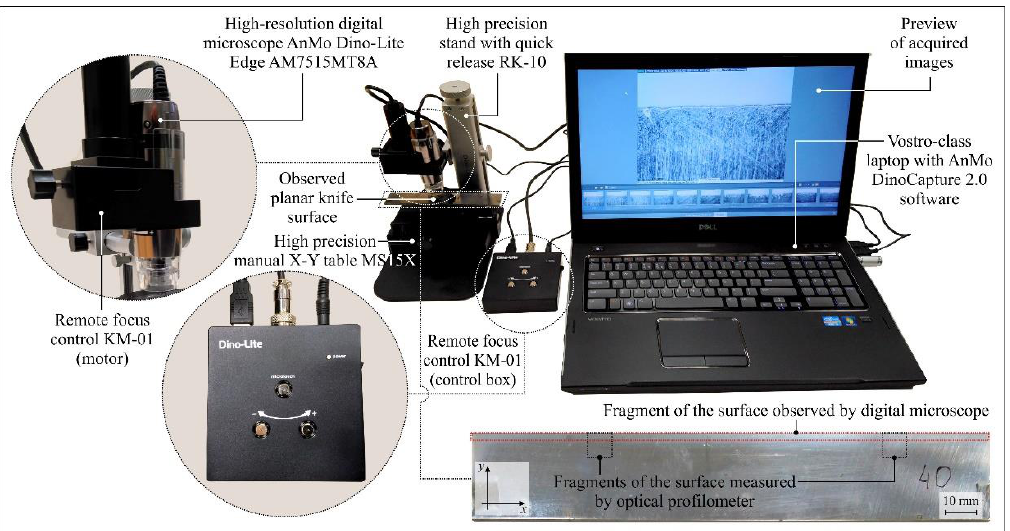
Figure 5. General view of the setup used for acquisition of digital images of selected fragments of the rake face of industrial planer knives based on the high-resolution digital microscope Dino-Lite Edge AM7515MT8A, produced by AnMo Electronics Corp.